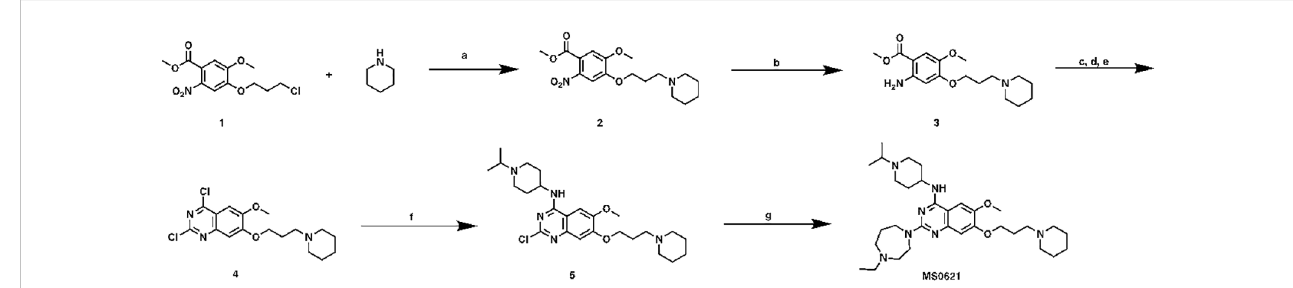
SCHEME 1 Synthetic route for MS0621 Reagents and conditions: (A) Piperidine, K 2 CO 3 , NaI, CH 3 CN, 80°C, overnight, 78%; (B) Fe, NH 4 OAc, EtOAC/H 2 O, re fl ux, overnight, 58%; (c) NaOCN, HOAc/H 2 O, rt, overnight; (D) NaOH, MeOH/H 2 O, re fl ux, 3h; (E) POCl 3 , PhEt 2 , re fl ux, 7h, 50%; (F)